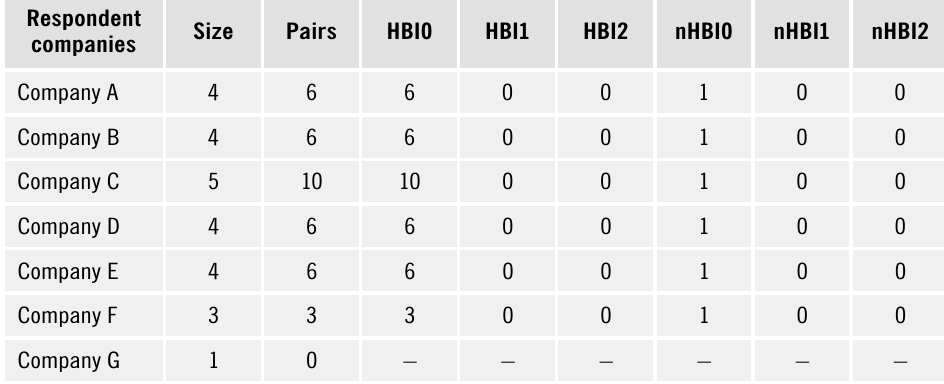
Table 9. Honest broker indices of the respondent companies with unweighted relations Respondent